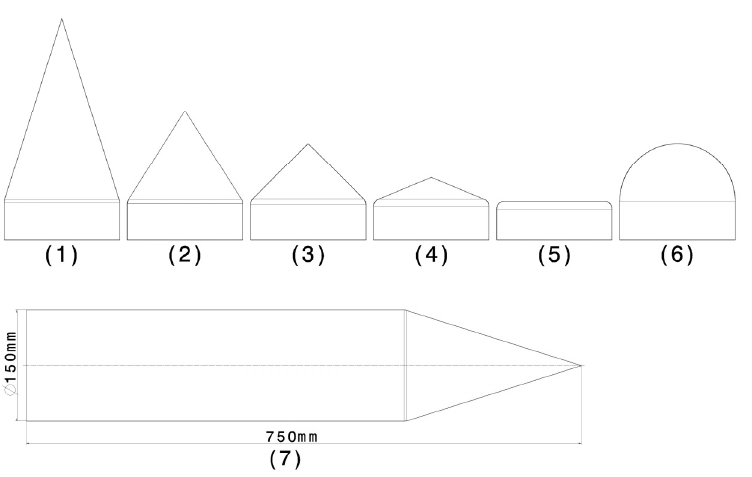
Figure 1. Tip contours: ( 1 ) 35°, ( 2 ) 65°, ( 3 ) 90°, ( 4 ) 135°, ( 5 ) flat, ( 6 ) round, and ( 7 ) projectile dimensions. As a target for the simulation, a concrete block with steel reinforcement was used. The block had the dimensions of 2750 × 1000 × 750 mm (width × height × depth) with three layers of steel reinforcement that had a diameter of 20 mm. The target geometry can be seen in Figure